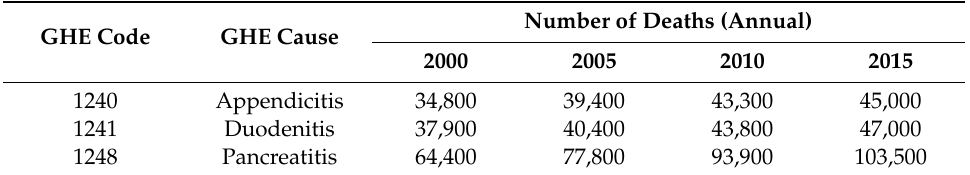
Table 1. Number of deaths due to Appendicitis, Pancreatitis, and Duodenitis in 2000, 2005, 2010, and 2015. GHE Code GHE